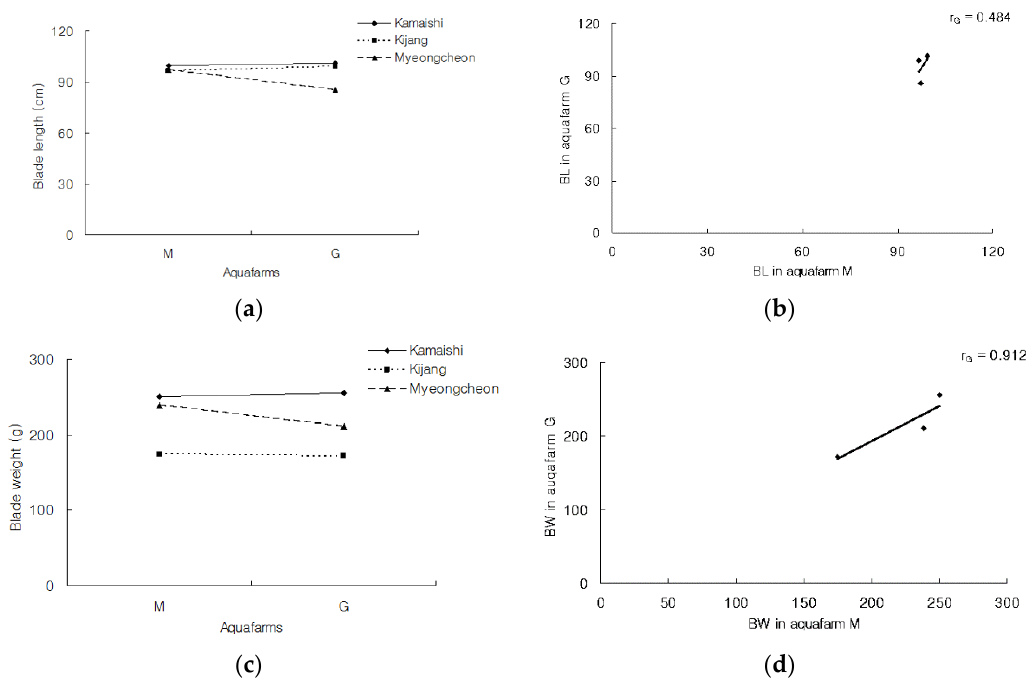
Figure 4. Genetic variation in the plasticity of blade lengths and blade weights plotted in two ways for three cultivars of U. pinnatifida at Myeongcheon (M) and Gyedo (G) aquafarms between January and May 2003. Left : Genotype × Environment interaction plots. Right : Scatter plots from which cross–environment genetic correlations between character states (rG) can be estimated. PCA-generated eigenvalues and loading factors for the data collected in 2003 are shown in Table 6. The eigenvalues of the first principal components at Myeongcheon and Gyedo were 9.120 and 8.456, respectively, which explained 82.9% and 76.9% of the total sample variance. Thus, sample